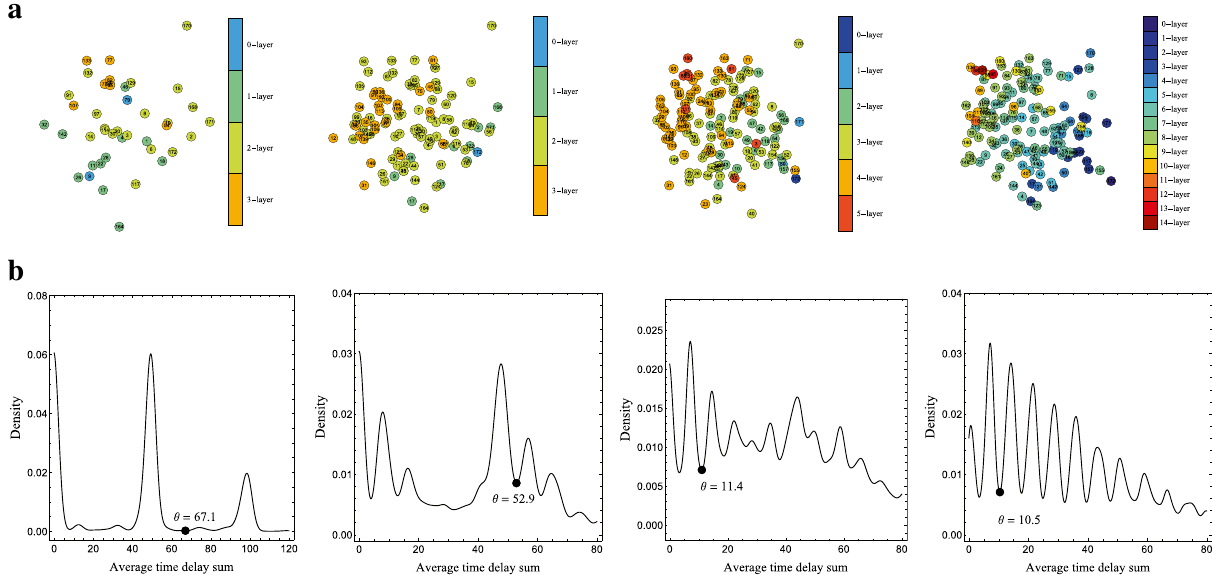
Figure 5. Estimated layer partitions and probability densities of the average time delay sum. ( a ) Layer partitions of the estimated propagation graphs for I 1 (cell location: t = 50 ), I 2 (cell location: t = 100 ), I 3 (cell location: t = 150 ), I 4 (cell location: t = 200 ), respectively from left. ( b ) Probability density of average time delay sum estimated by kernel density estimation for each dataset; I 1 , I 2 , I 3 , and I 4 , respectively from left. We used Gaussian kernel with a bandwidth with the parameter β = 0.25 . The black circles indicate threshold values adopted by our